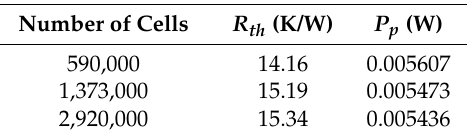
Table 2. Grid study